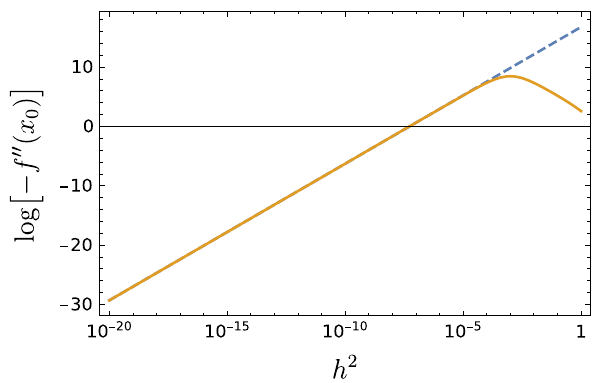
Fig. 11 The rescaled quadratic coupling ξ 2 as a function of h 2 for P = 2 and fixed value for the nontrivial minimum x 0 = 10 − 3 . Dashed line:EFTapproximationincludingthresholds,seeEqs.(C1),(C2).Solid line: weak- h 2 expansion, see Eq.